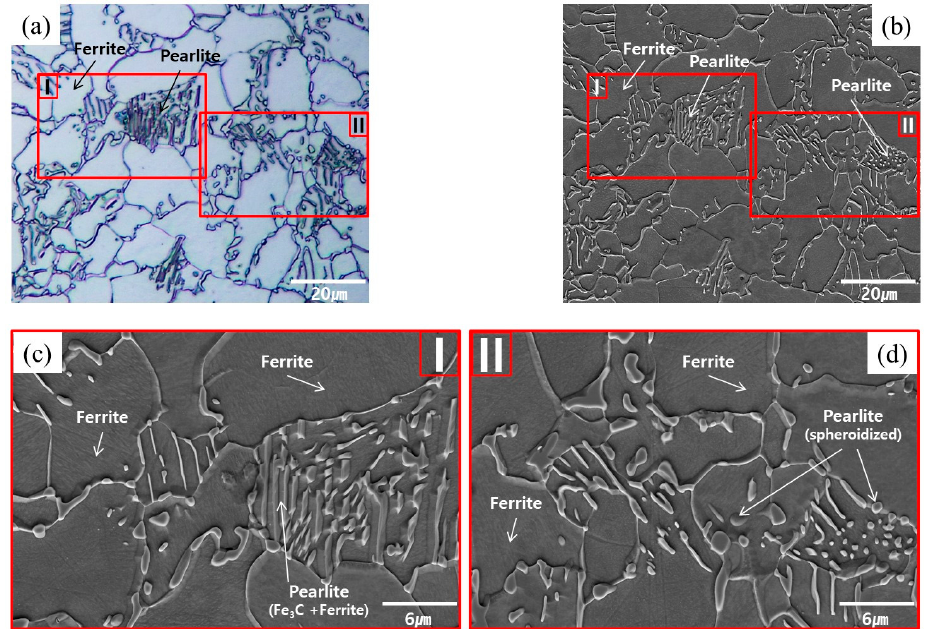
Figure 4. Microstructures of spheroidized and annealed specimen: ( a ) OM image (×1000); ( b ) SEM image (×1000); ( c ) SEM image in section I (×3000); ( d ) SEM image in section II (×3000). Table 2. Grain size of raw and heat-treated AISI 1035 specimens. Min. Max. Average Raw